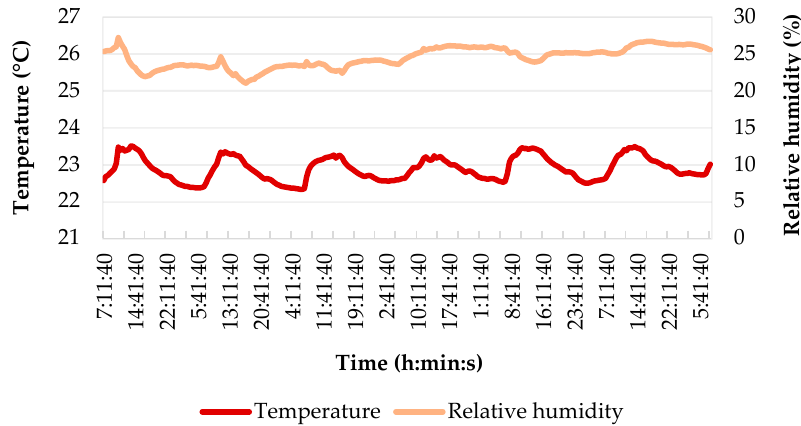
Figure 6. Indoor air temperature and relative humidity fluctuations for RHS.